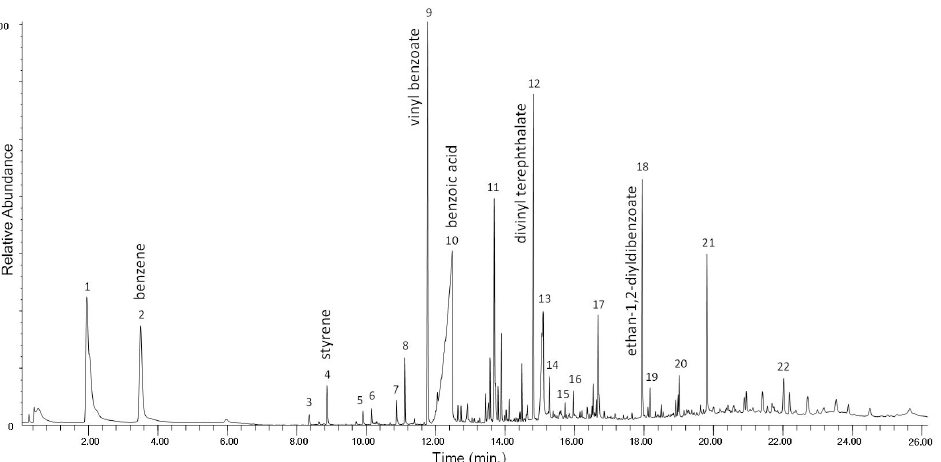
Figure 6. Chromatogram obtained in the Py–GC–MS analysis of the unaged polyethylene terephtha- late (PET-0w). Peak identification is reported in Table S3 in Supplementary